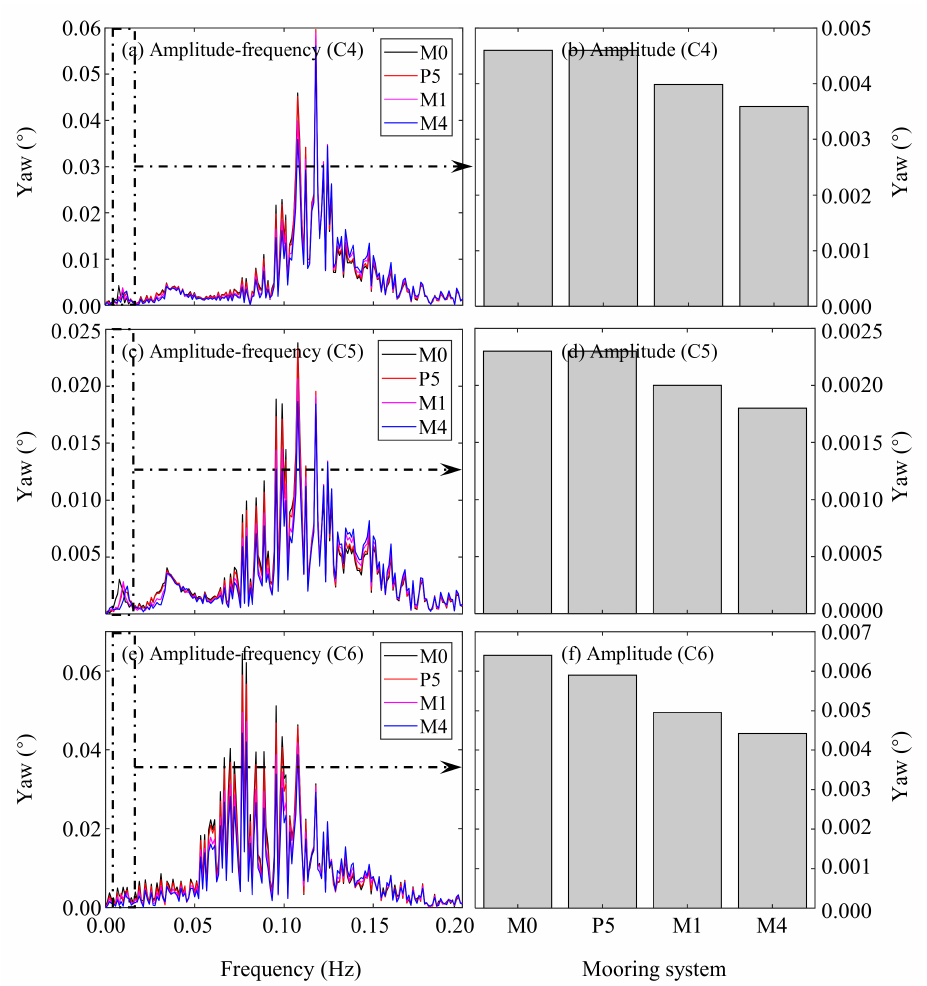
Figure 24. Wind turbine yaw movement in frequency domain with M0, P5, M1, and M4 when under: ( a ) amplitude-frequency (C4); ( b ) amplitude (C4); ( c ) amplitude-frequency (C5); ( d ) amplitude (C5); ( e ) amplitude-frequency (C6); ( f ) amplitude